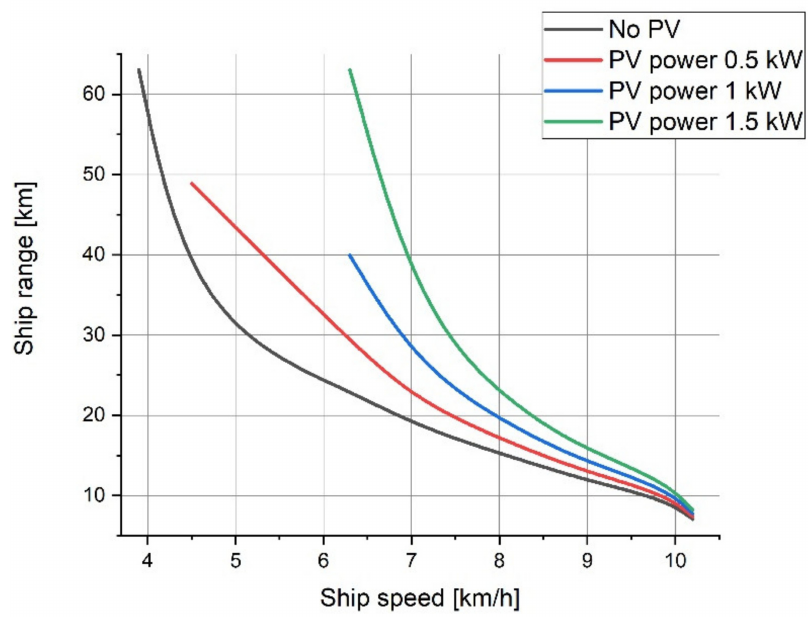
Figure 12. Prognosis of the vessel’s operating range during travel at various speeds in favourable atmospheric conditions; alternatives with and without photovoltaic installation (PV) and various power levels generated by the